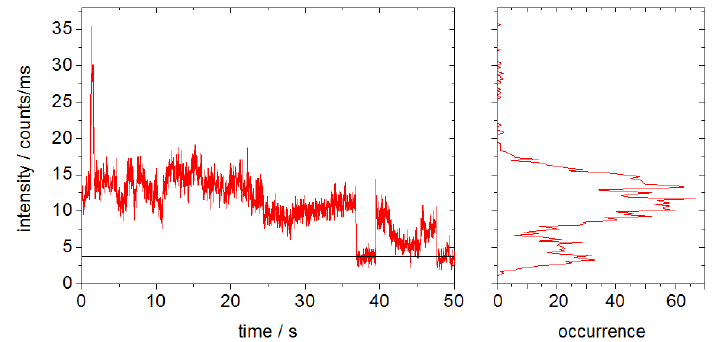
Figure 6. An example of a single molecule fluorescence trajectory with intensity histogram recorded at 33°C showing different types of dynamics. The black horizontal line shows the background level.